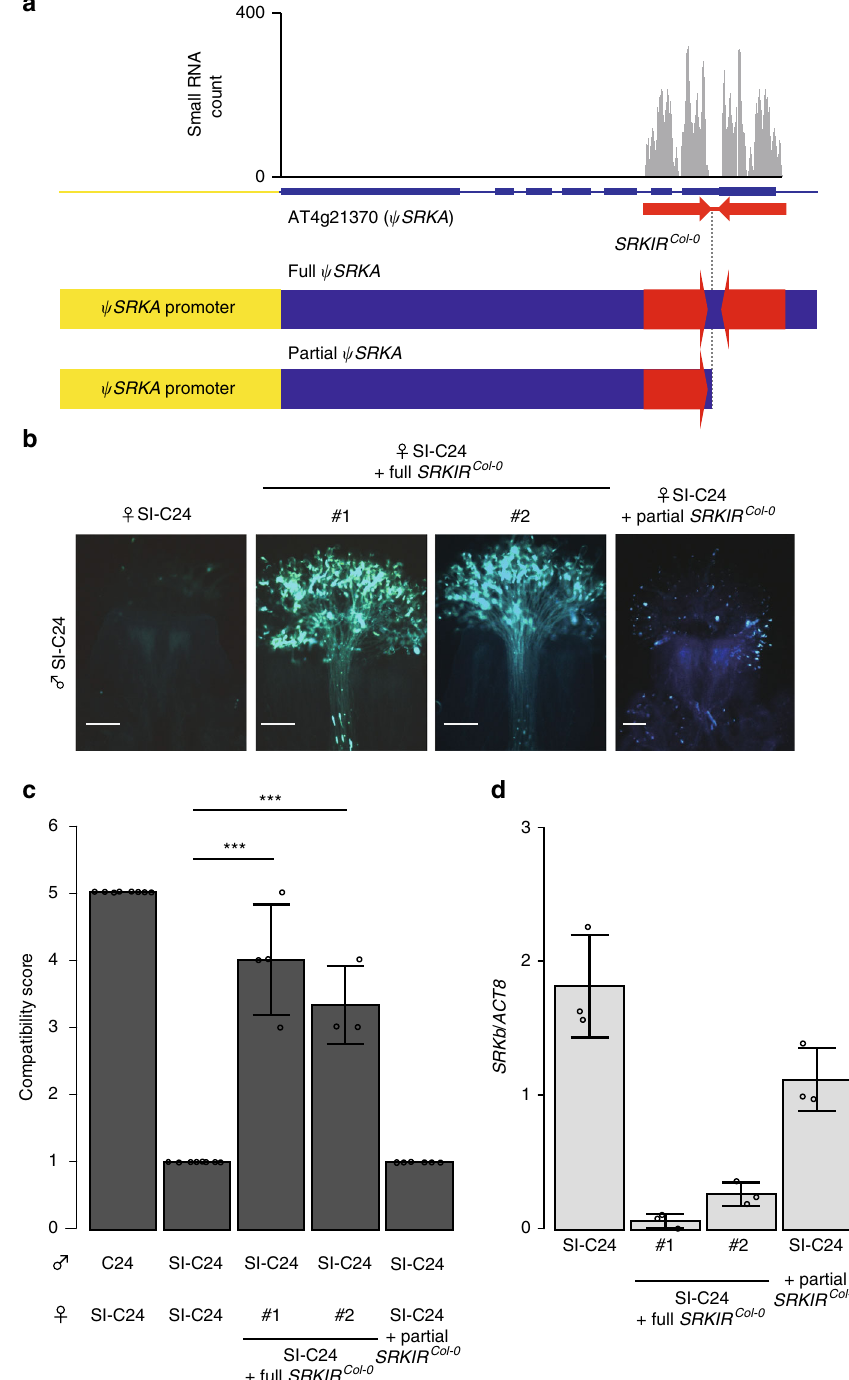
Fig. 2. Introduction of SRKIR Col-0 into the SI-C24 line breaks down SI. a Schematic drawing of the ψ SRKA locus of Col-0. b Representative fl uorescent images of aniline blue-stained pistils at stage 14 three hours after pollination. #1 and #2 indicate pistils from two independent fi rst generation transformants. Scale bars = 100 µ m. c Summary of pollination tests. Statistically signi fi cant differences based on Dunnett ’ s test are indicated by ***( p < 0.005). The exact p -values found by Dunnett ’ s test compared to the ♀ SI-C24 × ♂ SI-C24 cross were 4.66e − 07 and 1.84e − 05, from left to right. Error bars indicate standard deviations. The number of pistils pollinated (from left to right): n = 8, n = 8, n = 4, n = 3, n = 6. d Relative mRNA accumulation levels of SRKb compared to ACT8 in stigmatic tissues of the indicated lines. Error bars indicate standard deviations from independent RNA extraction trials ( n =